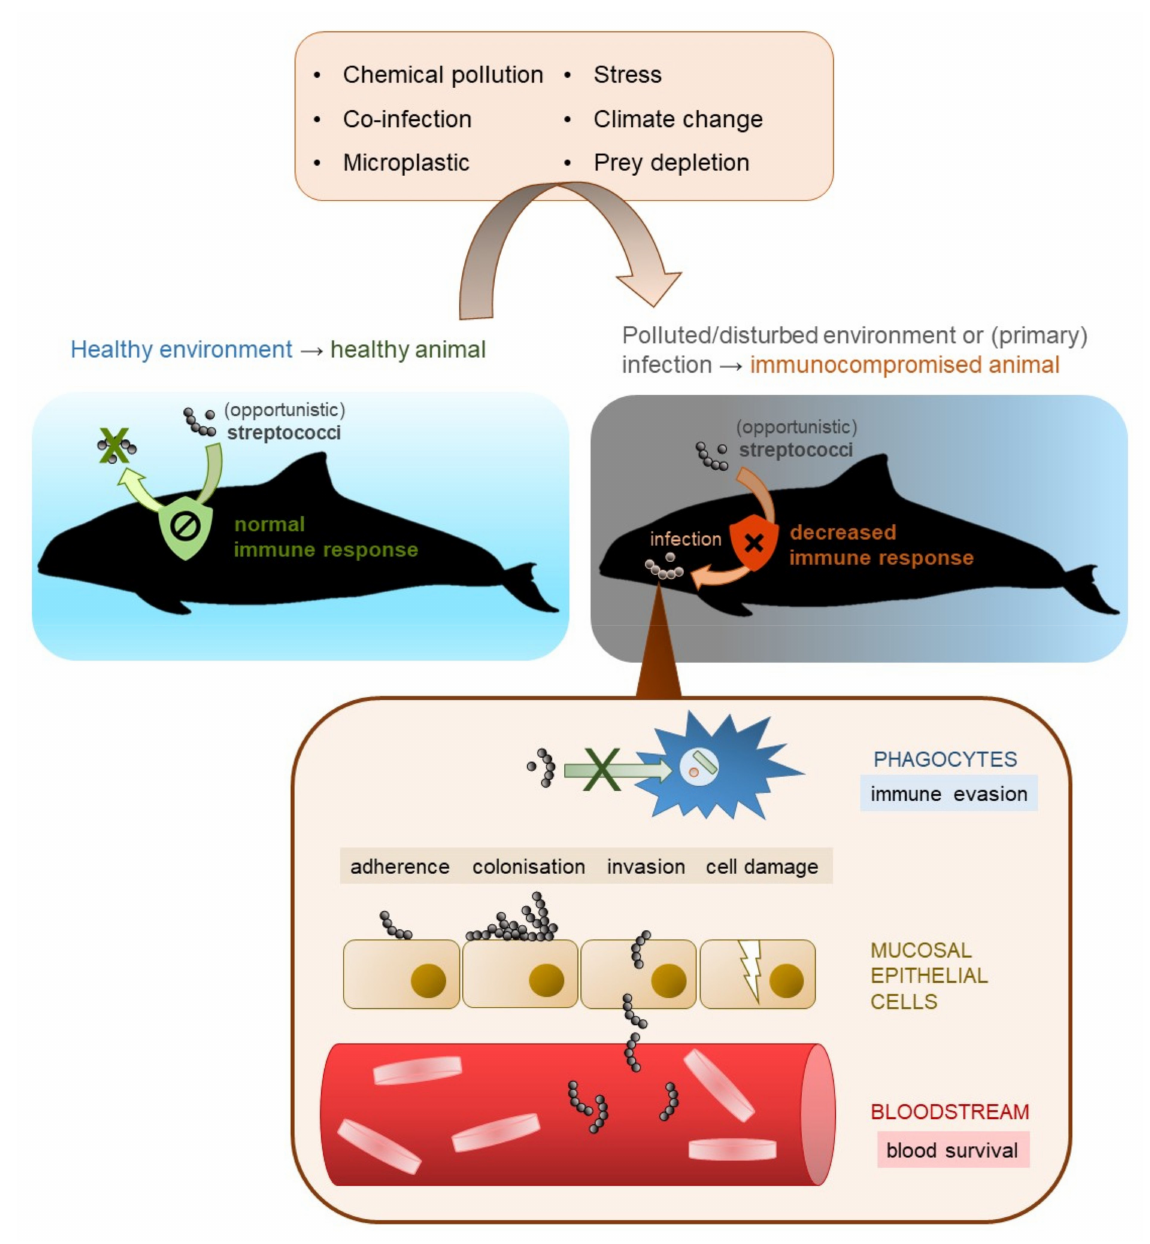
Figure 2. Schematic representation of the infection of marine mammals with (opportunistic)